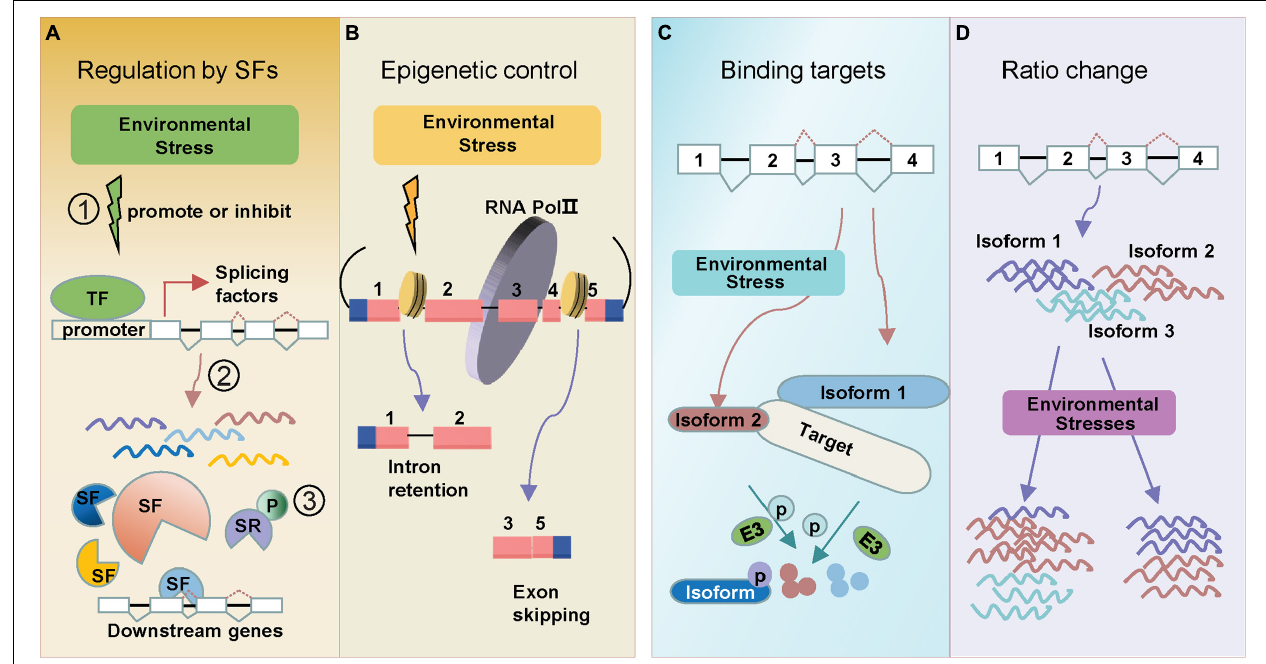
FIGURE 1 | Regulation types of AS in response to environmental stresses. Alternative splicing under environmental stresses. (A) Stresses can induce alternative splicing through splicing factors (SF). SFs are regulated at multiple levels: (1) environmental stress promotes or inhibits transcription of splicing factors; (2) many splicing factors themselves generate alternative splicing events which further regulate splicing of downstream genes; (3) SR proteins can be phosphorylated (labeled “P”) under stress. (B) Environmental stresses change epigenetic marks which alter the pol II elongation rate, leading to either Intron retention (IR) or Exon skipping (ES). (C) Environmental stress induces different splicing isoform (isoform 2), which tends to bind the same target (protein or DNA) that full-length isoform (isoform 1) binds. One example is the splice isoforms involved in the regulation of protein degradation. (D) Alternative splicing generates transcript isoforms with variable abundance. Environmental stresses lead to the altered ratios of splice variants. Exons are displayed as boxes and introns as lines in gene